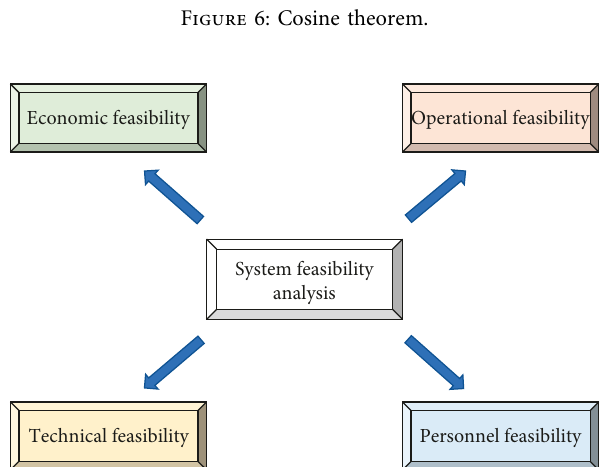
Figure 7: System feasibility